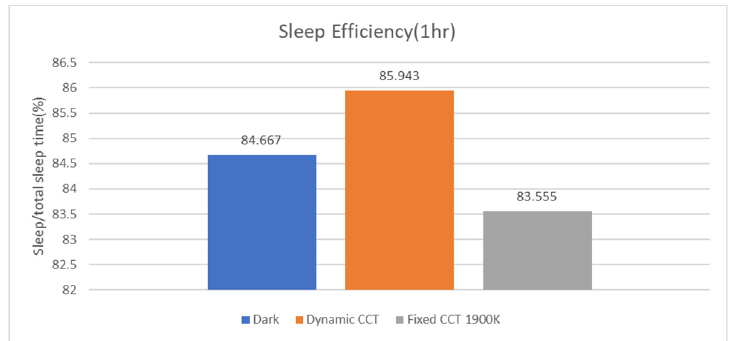
Figure 25. Bracelet sleep efficiency analysis.